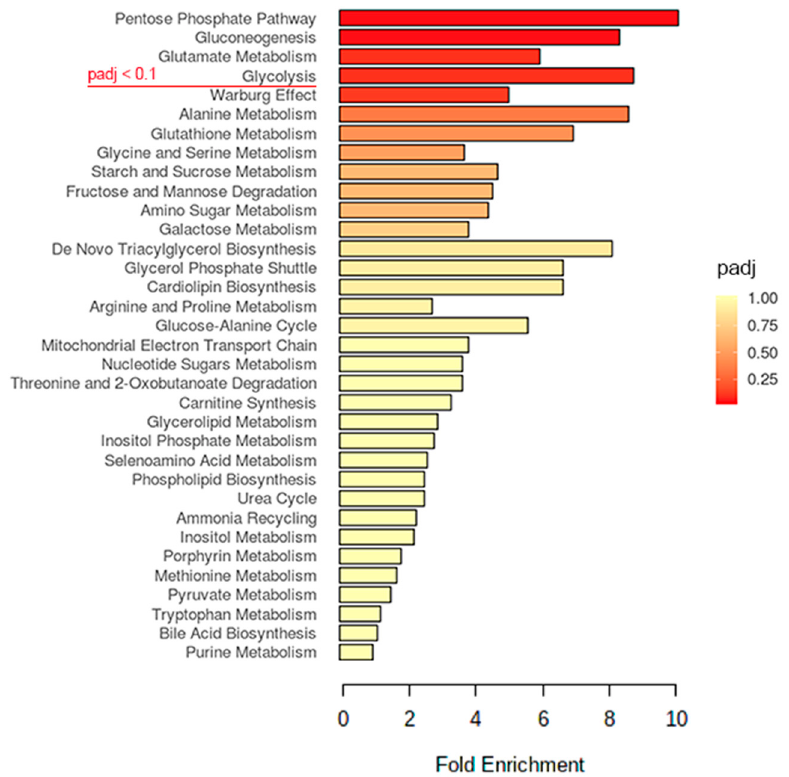
Figure 2. The pathway-associated metabolite sets enrichment analysis of polar metabolites for EV-A71-infected hNPCs. Pathways above the red line achieved padj < 0.1 when compared with the mock-infected control. The analysis was performed on MetaboAnalyst 4.0.